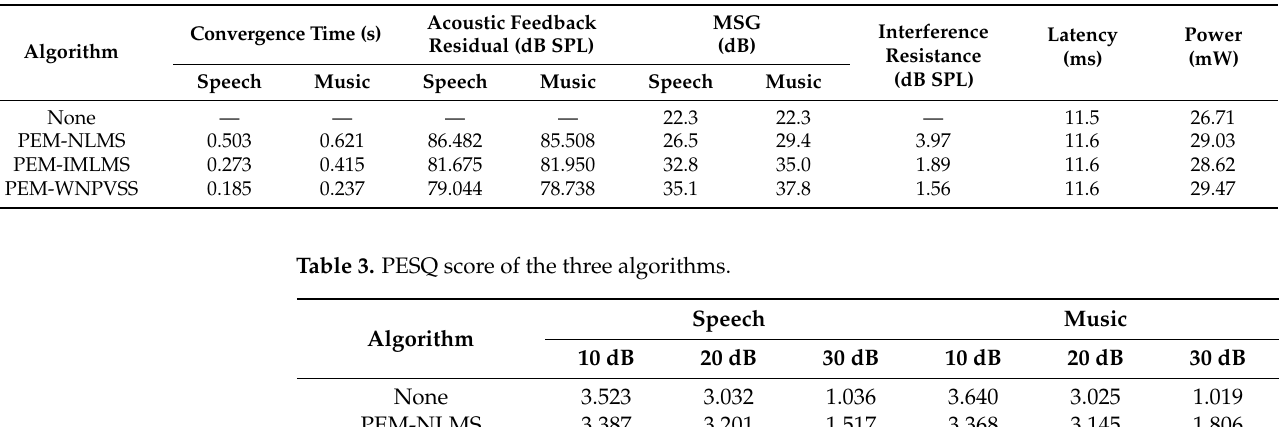
Table 2. Acoustic feedback cancellation performance of the three algorithms.